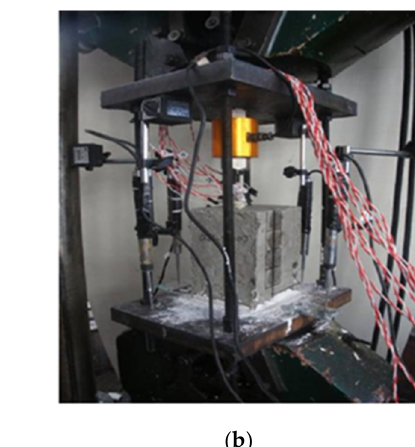
Figure 6. Steel reinforcement: Waterproofing treatment of steel bars. Adapted with permission from [29].